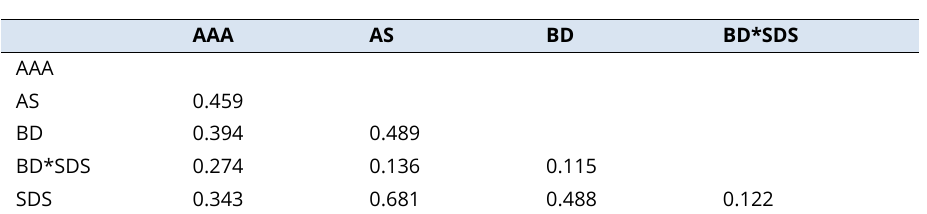
Discriminant Validity (Heterotrait-Monotrait